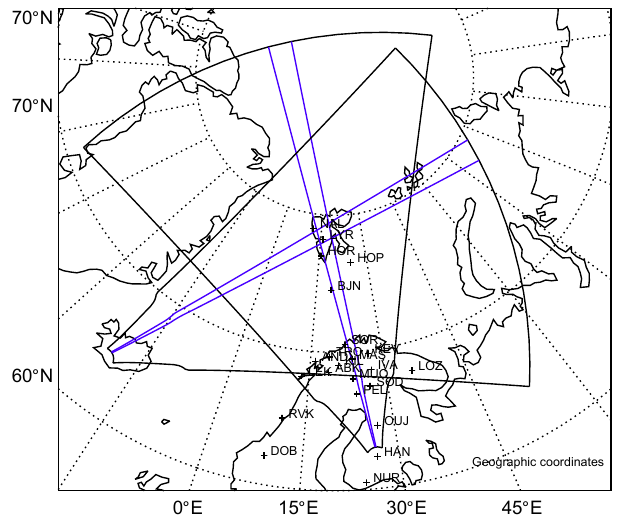
Fig. 1. The fields of view of Channel A (black) and Channel B (blue) of the Hankasalmi, Finland and Þykkvibær, Iceland Super- DARN radars during the interval under